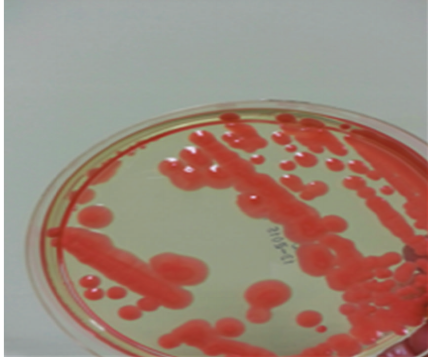
Figure 3: The yeast colonies on the SDA after